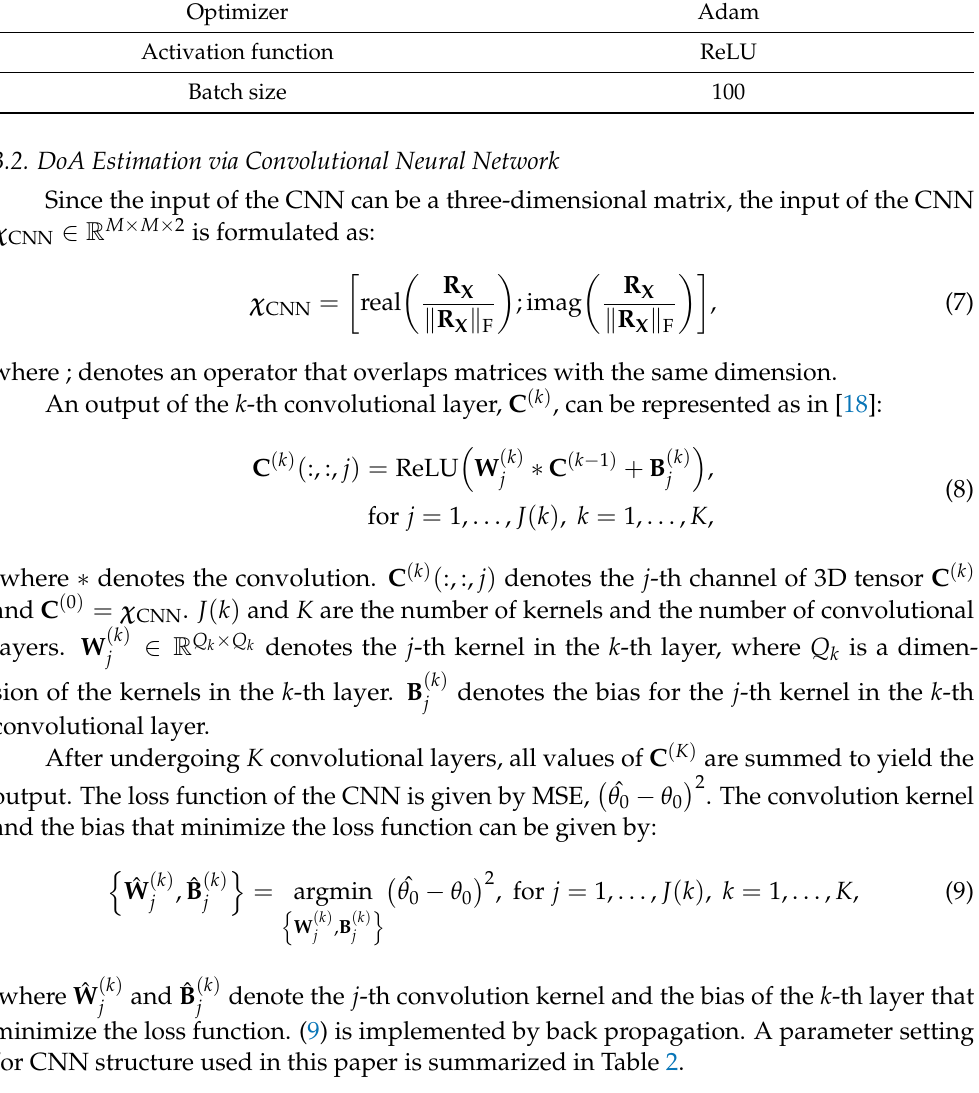
Table 1. Parameter setting for DNN structure. Parameter Value (or Type) Number of layers ( L ) 2 Size of layers ( I ( l ) for l = 1, . . . , L ) 600, 600 Loss function MSE Optimizer Adam Activation function ReLU Batch size